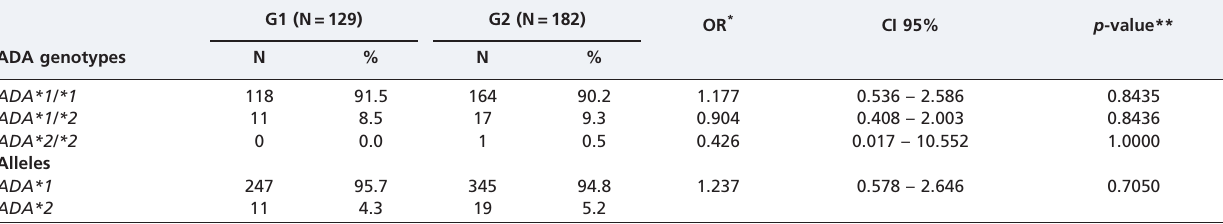
Table 1 - The frequencies of ADA genotypes and alleles in women with (G1) and without (G2) a history of recurrent spontaneous